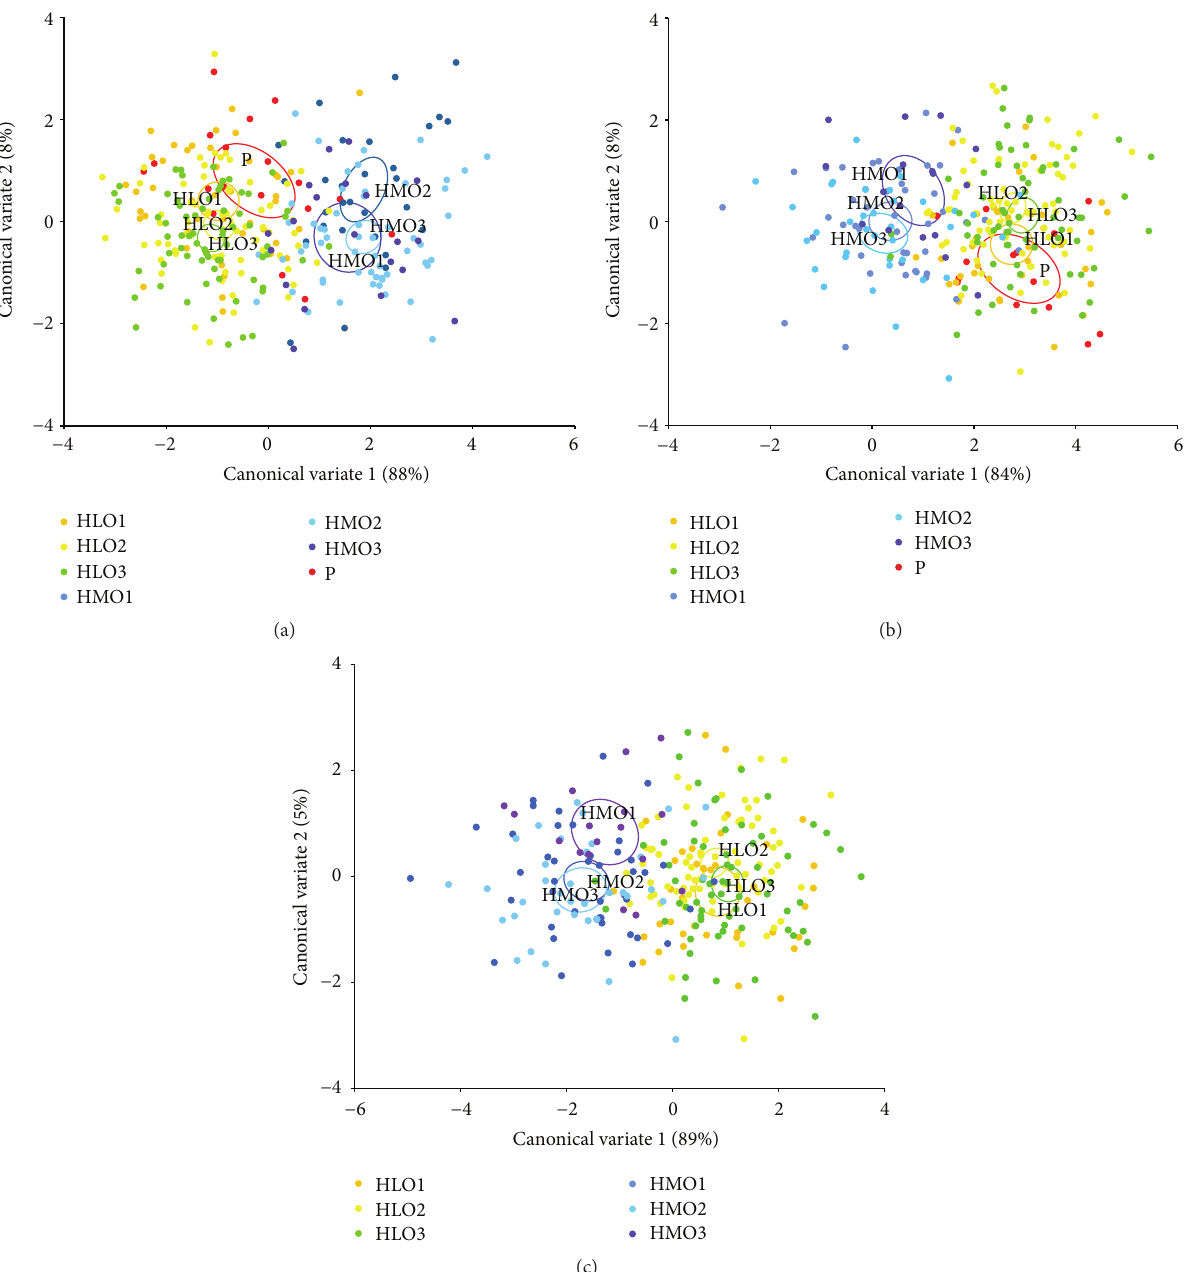
Figure 3: Factorial maps in the plane of the two canonical factors of shape variation for wing (CV1 and CV2) presenting the distribution of the phenotypesofwingshapeinfemales(a),males(b),and(c)malesoffspring(aftersizecorrection).Theellipsesrepresenttheconfidenceinterval of the average shape of each group with a probability of 95%. P (parent), HL (hemolymphagy = fed on cockroaches), HM (hematophagy = fed on mice), O1 (first offspring), O2 (second offspring), and O3 (third